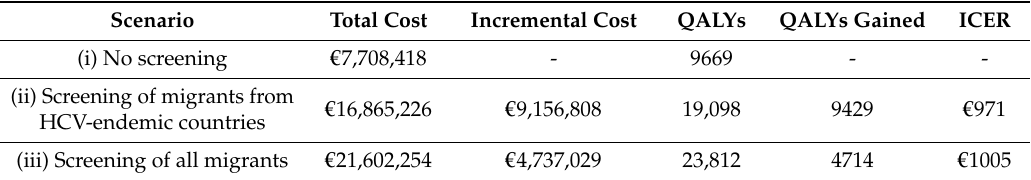
Table 4. Incremental cost-e ff ectiveness of di ff erent strategies of HCV screening and treatment among migrants in The Netherlands.